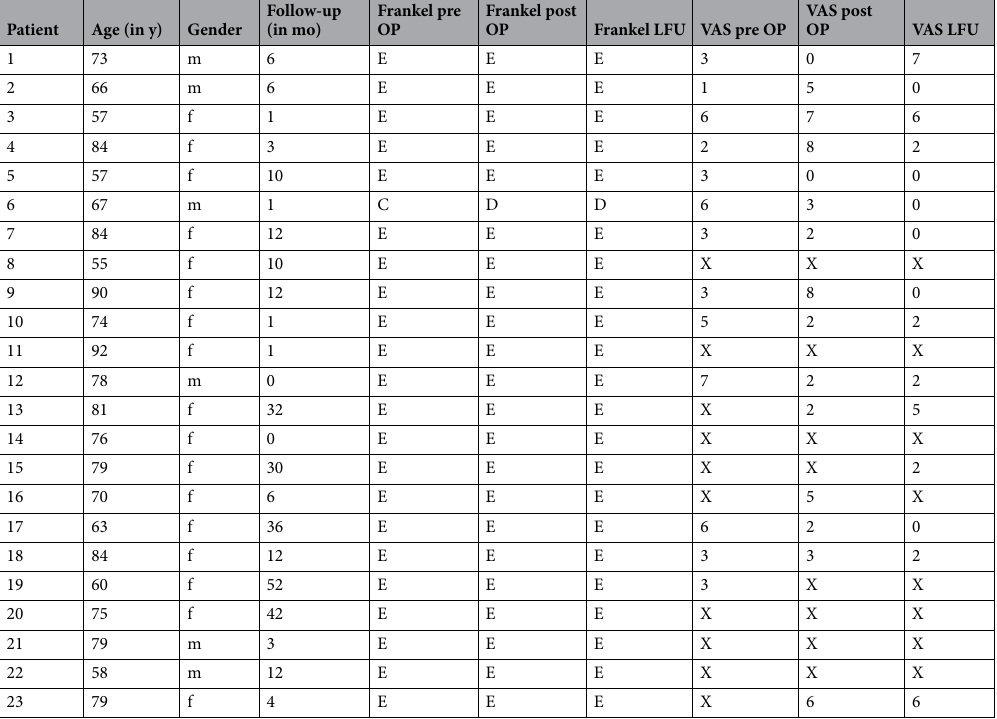
Table 1. Clinical data. y years, m male, f female, mo months, OP operation, LFU last follow-up, VAS visual analogue scale, X no value